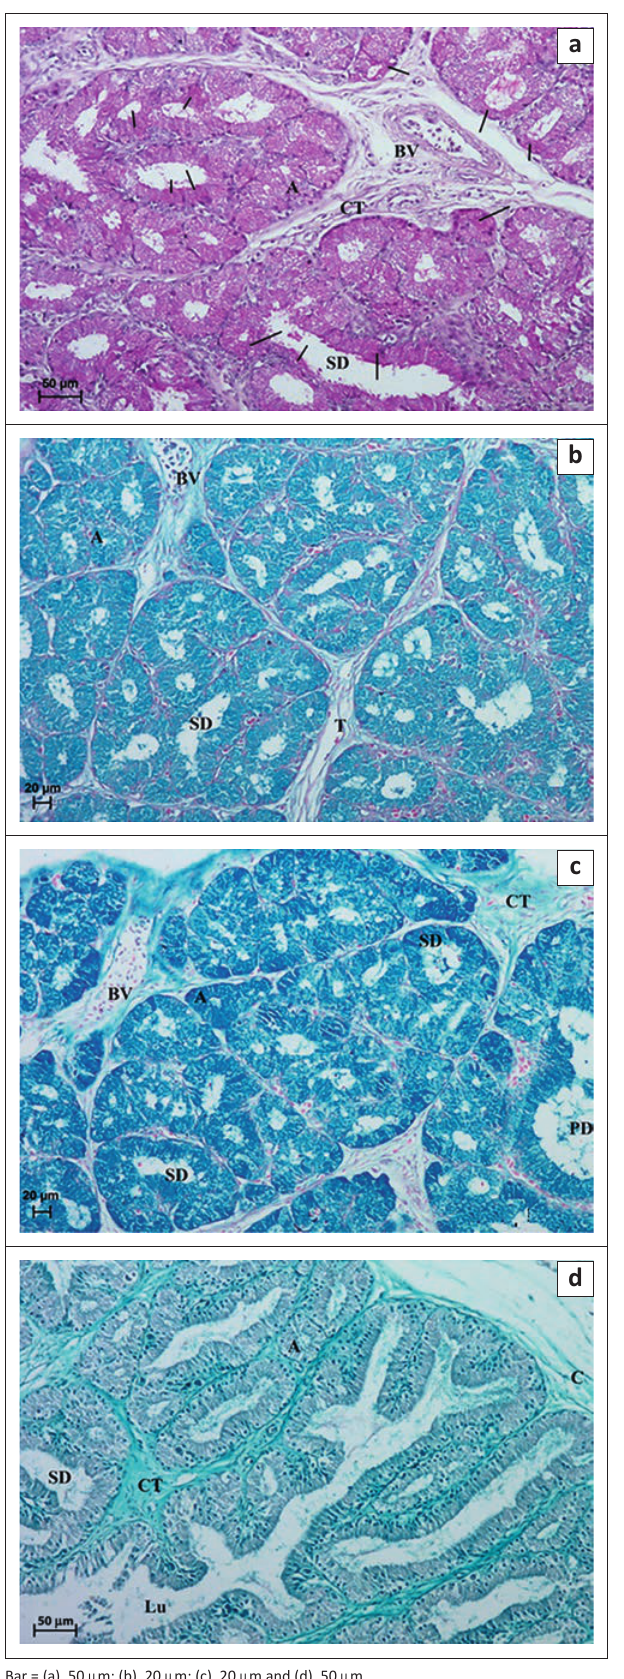
FIGURE 8: Light micrograph of the lacrimal gland in African black ostrich in group 4. (a) 6-months-old, (b) 6-months-old, (c) 5-months-old and (d)